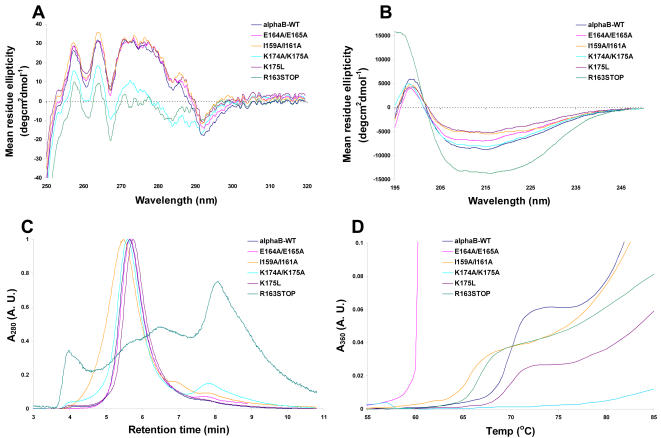
Biophysical characterization of wild-type and mutant αB-crystallin proteins.
A, Near- and B, Far-UV CD spectra of wild-type and mutant αB-crystallin proteins. Spectra were acquired on a Jasco J-810 spectropolarimeter with 1 cm and 0.01 cm pathlength cells for the near- and far-UV regions, respectively. Protein concentrations were ∼1 mg/mL prepared in 10 mM sodium phosphate buffer, pH 7.4. C, Size-exclusion HPLC traces for wild-type and mutant αB-crystallin proteins in 50 mM sodium phosphate buffer, pH 7.2. Samples (10 µL of a 10 mg/mL solution) were injected onto the column and eluted at 0.5 mL/min. D, Thermostability profiles of αB-crystallin mutants. Protein samples were 0.2 mg/mL in 50 mM sodium phosphate buffer, pH 7.4. Thermal ramping was 1°C/min and light scattering at 360 nm was monitored as an indicator of protein precipitation.